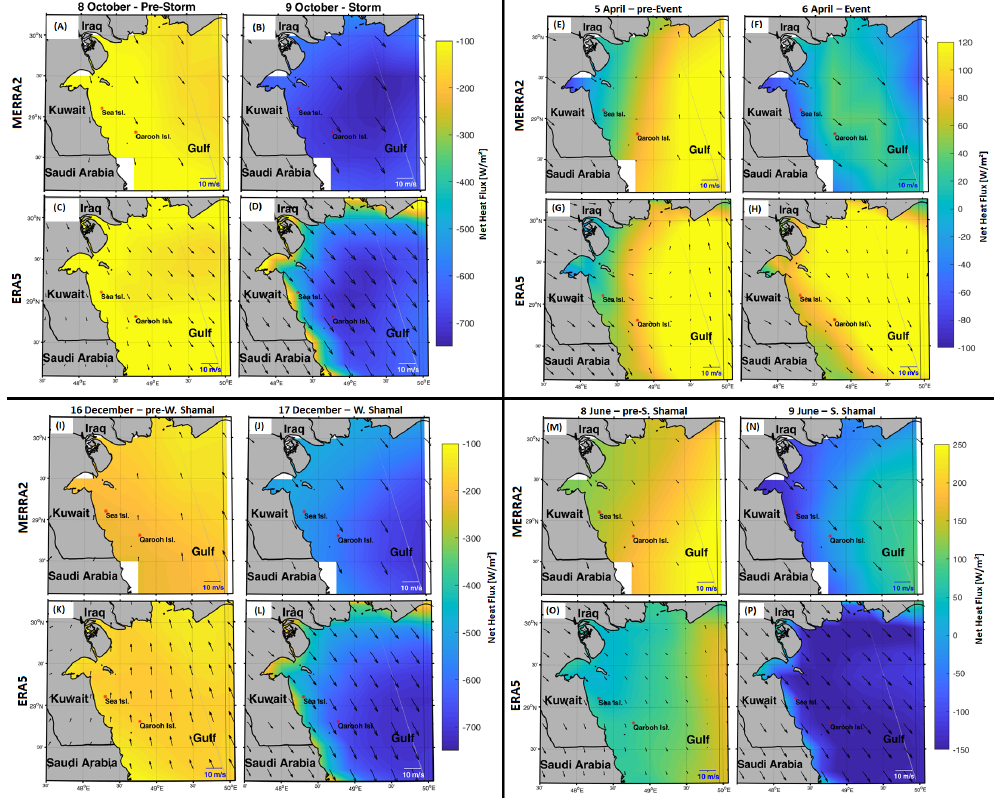
Figure 7. Wind speeds (vectors) and net heat fluxes (colors) before and during storm events. ( A – D ) In autumn; MERRA2 ( A ), ERA5 ( C ) the day before tropical storm 2 in autumn (8 October 2013) and MERRA2 ( B ), ERA5 ( D ) the day of the storm (9 October 2013) event. E – H : Similar to A – D but for the spring wind event. I – L : similar to A – D but for the winter Shamal event. M – P are similar to A – D but for the summer Shamal